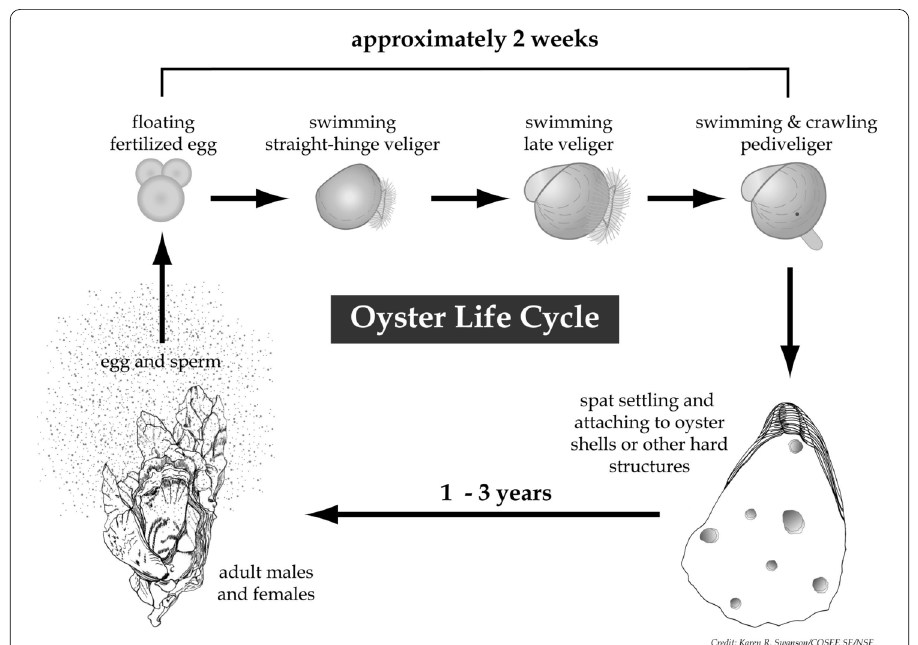
Figure 1 Oyster’s life cycle. credit: Karen R. Swanson/COSEE